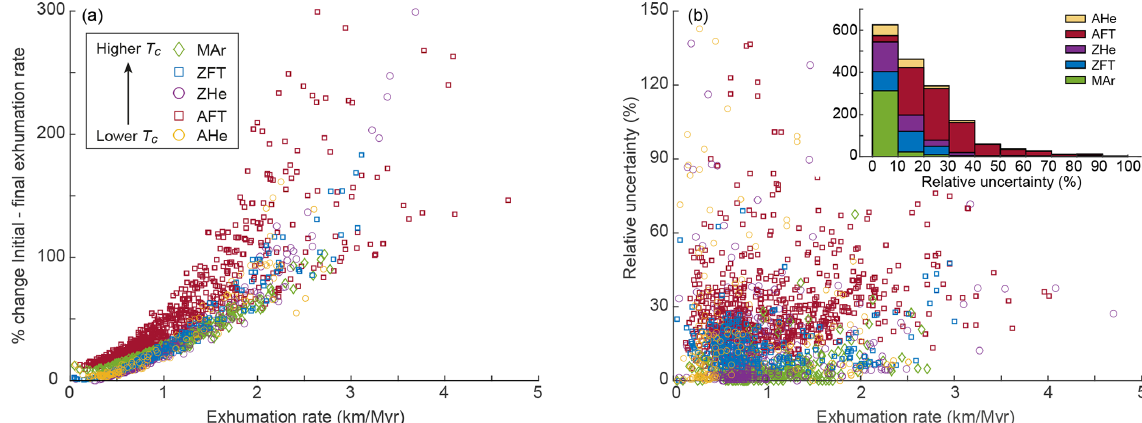
Figure 5. Impact of including perturbations to the geotherm and T c in estimates of exhumation rate and uncertainties in exhumation-rate calculations. (a) Comparison of initial exhumation rate ( ˙ e init ; assuming a linear geothermal gradient and nominal closure temperatures) for the Himalayan data against final exhumation rate ( ˙ e ), calculated using the age2exhume method. The impact is expressed as a percent change between the two results; i.e., 100 × ( ˙ e init − ˙ e ) / ˙ e . Symbols indicate different thermochronometric systems. (b) Relative uncertainty in exhumation rate calculated by propagating uncertainty in age. Symbols are as in (a) . Inset shows stacked histograms of relative uncertainty for different systems. See text for discussion.